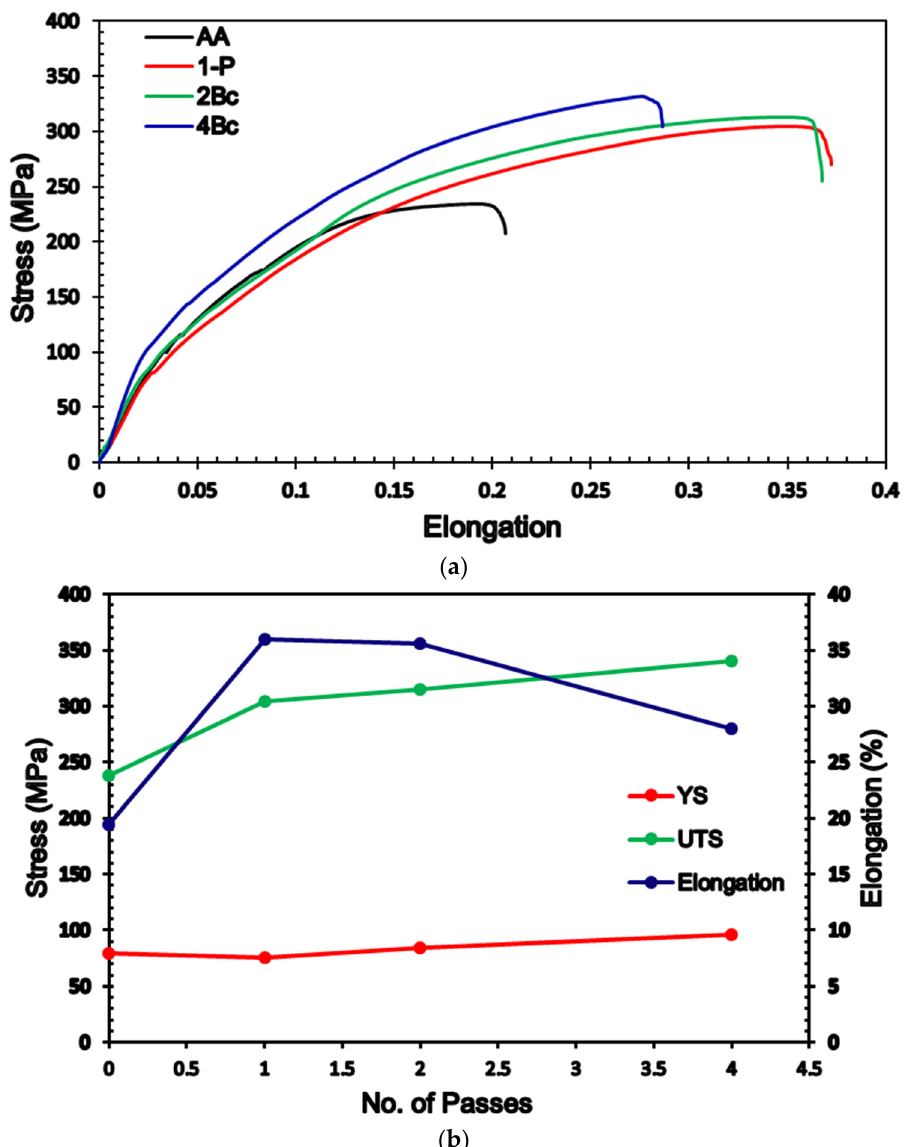
Figure 16. ( a ) Stress-strain curves and ( b ) variation of UTS, YS, and elongation % of ZK30 billets as a function of number of passes.